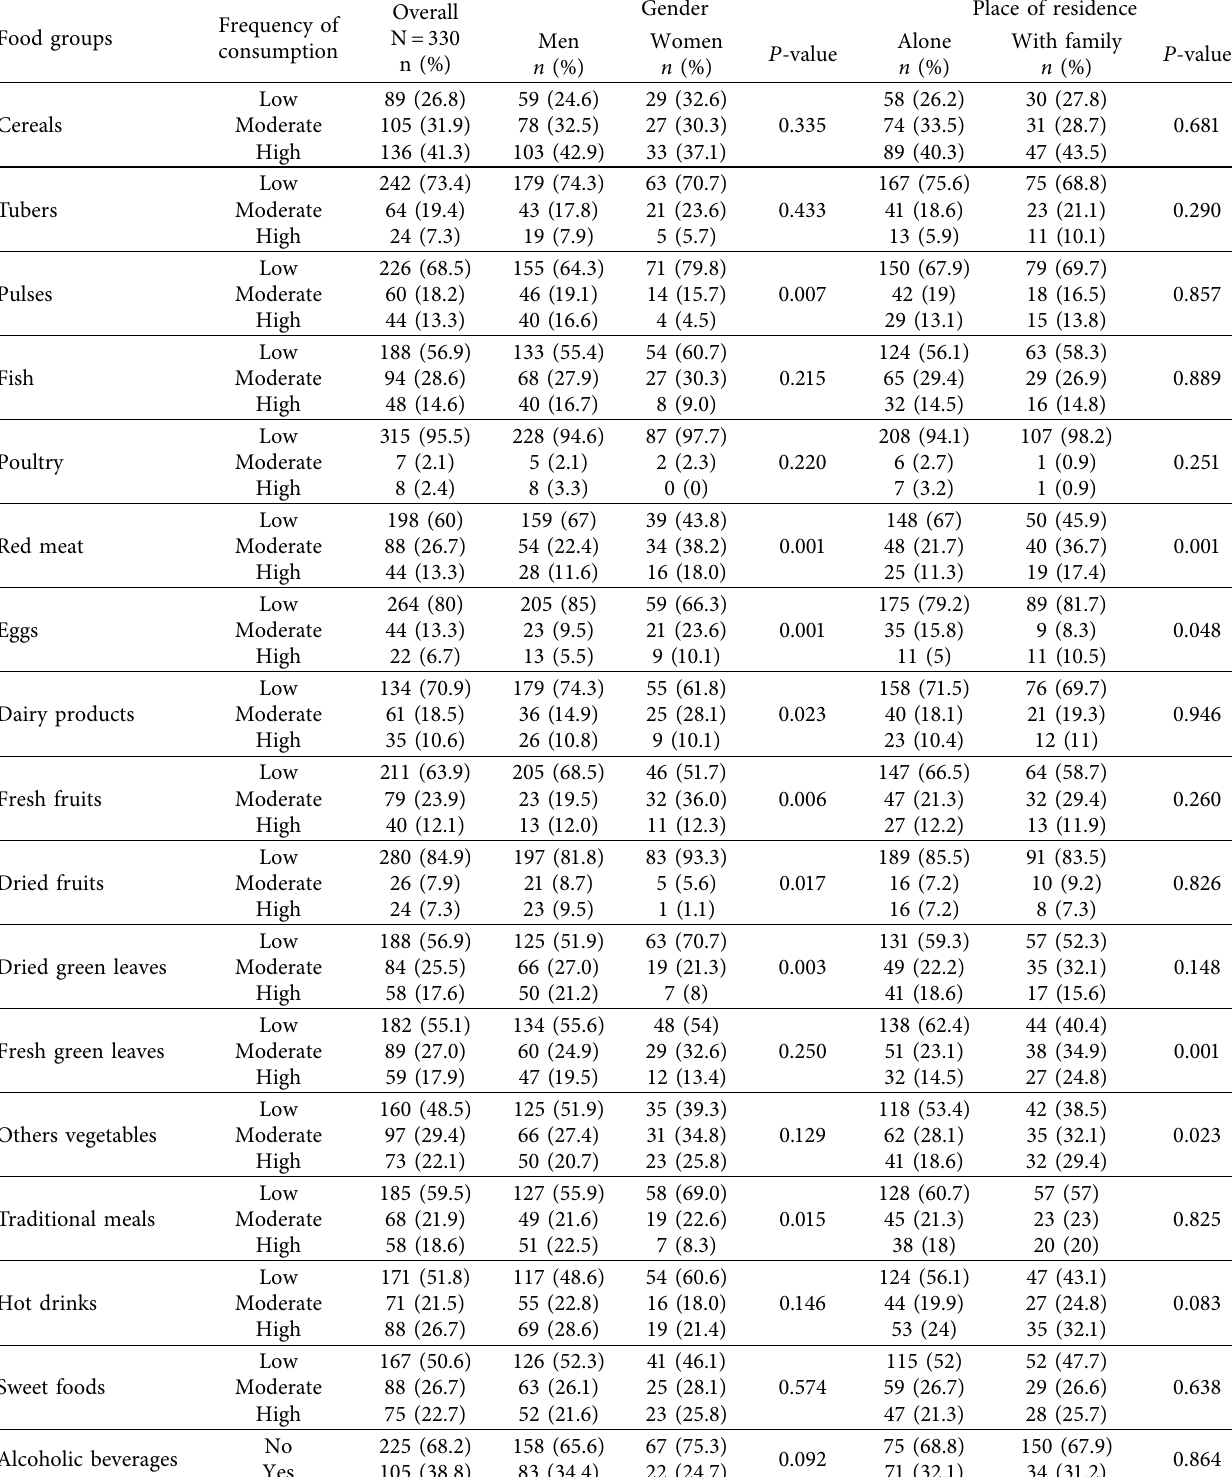
Table 6: Description of food habits of the